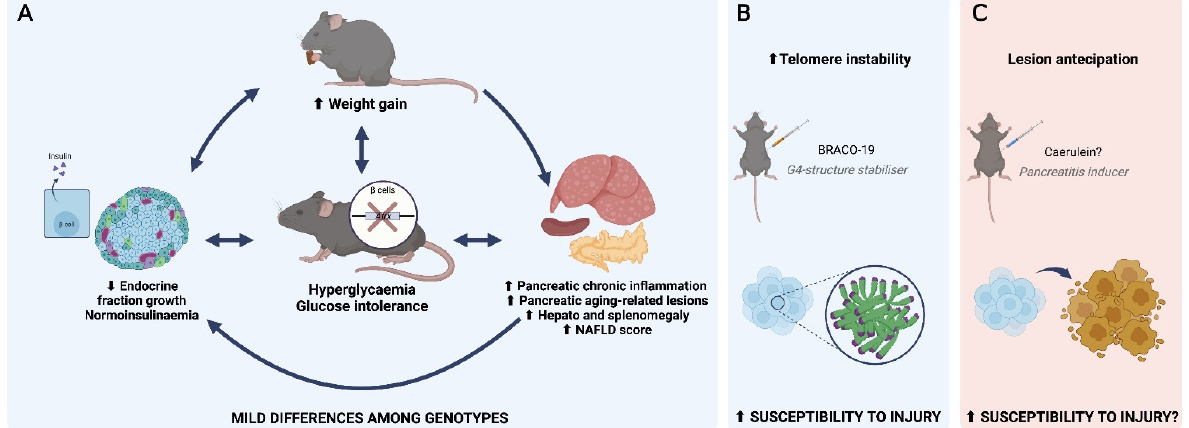
Figure 7. Atrx KO mice as a non-obese dysglycaemic model. Atrx disruption at β cells seems to induce a state of dysglycaemia, characterised by hyperglycaemia and glucose intolerance ( A ); this is accompanied by increased weight gain leading to overweight (not obesity), which could both explain the origin and be a consequence of the impaired metabolism. Atrx KO mice seem to be unable to double its endocrine fraction with ageing, although insulinaemia values did not seem to be altered. As a consequence of ageing, pancreatic chronic inflammation (CI), ageing-related lesions, and non-alcoholic fatty liver disease (NAFLD) are present in all genotypes with a mild predominance in Atrx KO individuals. A slight increase of hepato and splenomegaly was noticeable in 15–24-month-old Atrx KO mice. Genotype-related differences in pancreatic CI scores were only noticeable during the first year of life. Similarly to exogenous glucose administration, BRACO-19 intake also induced changes in Atrx KO mice, by causing telomere instability, a state that would predispose endocrine pancreas to injury ( B ). We hypothesise if the exogenous administration of a pancreatitis inducer like caerulein would also increase susceptibility to injury allowing for an anticipation of lesion formation in endocrine pancreas, as previously observed ( C ) [50].